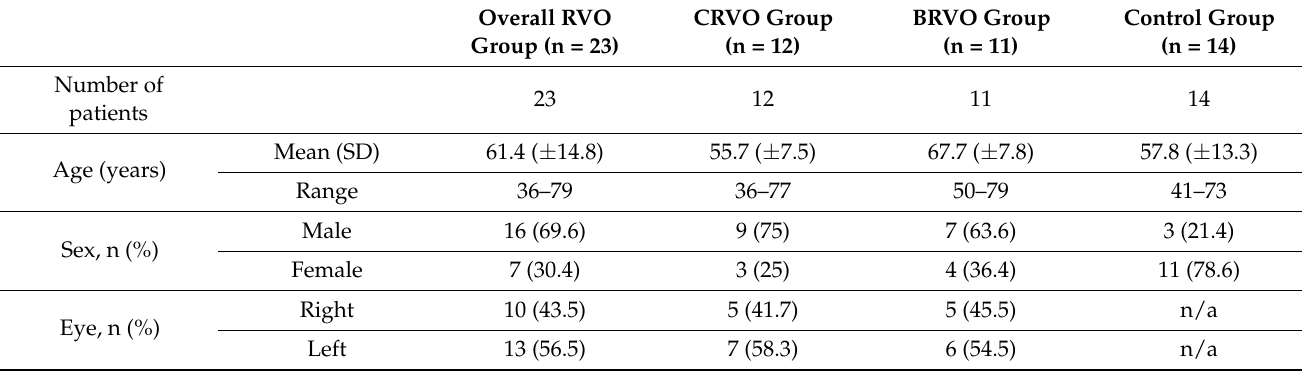
Table 1. Basic demographics of the analyzed